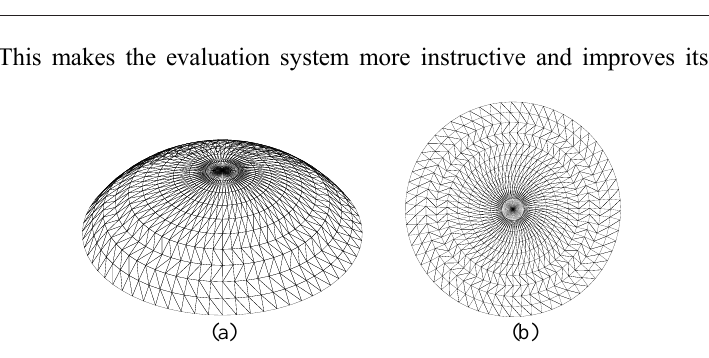
Fig. 5. Flattening of a partial sphere: (a) a mesh of partial-sphere, and (b) the flattening result of (a).